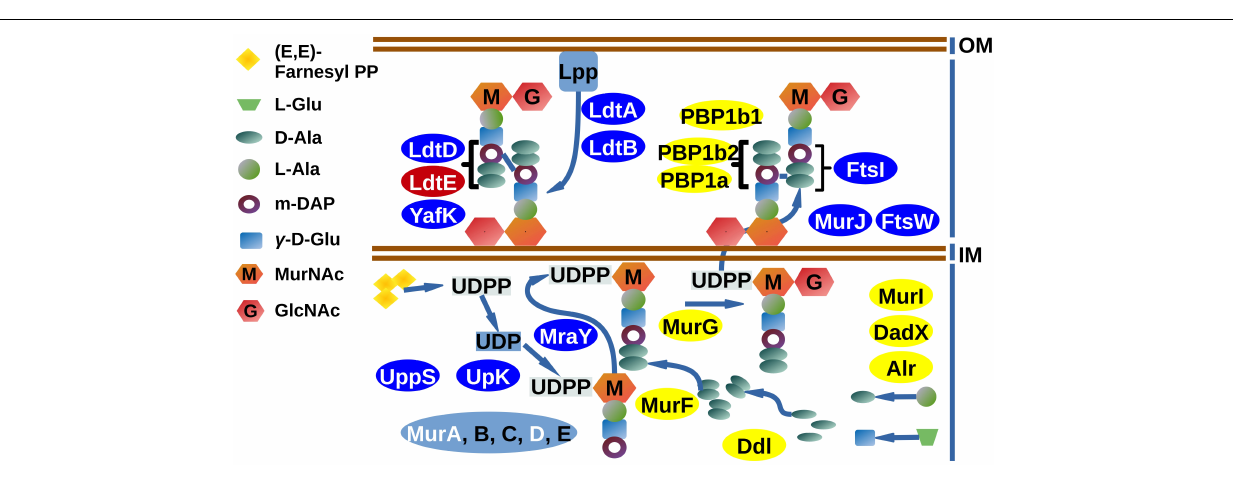
FIGURE 7 | DEGs are part of the canonical cell wall biogenesis pathway. DEGs in the cKD24 mutant that were downregulated (blue ovals) or upregulated (red ovals) with a cutoff threshold of log2FC ≥ 1.5 and P-adj/FDR ≤ 0.02. Non-DEGs are shown in yellow ovals. DEGs downregulated in the murA-murE gene cluster (light blue oval) are shown in white letters. The pathway map is based on KEGG Pathway Maps: Peptidoglycan biosynthesis, D -Alanine, and D -glutamate